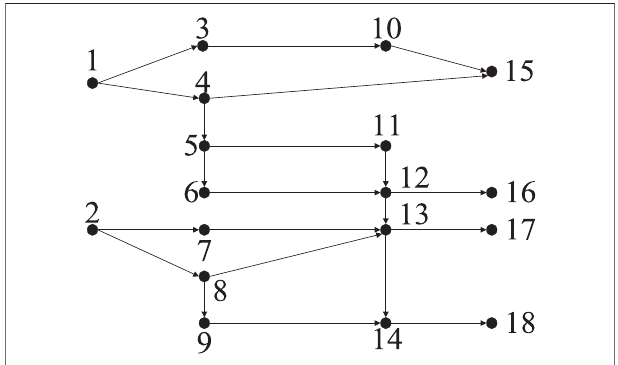
FIGURE 2 | The weighted directed graph of the